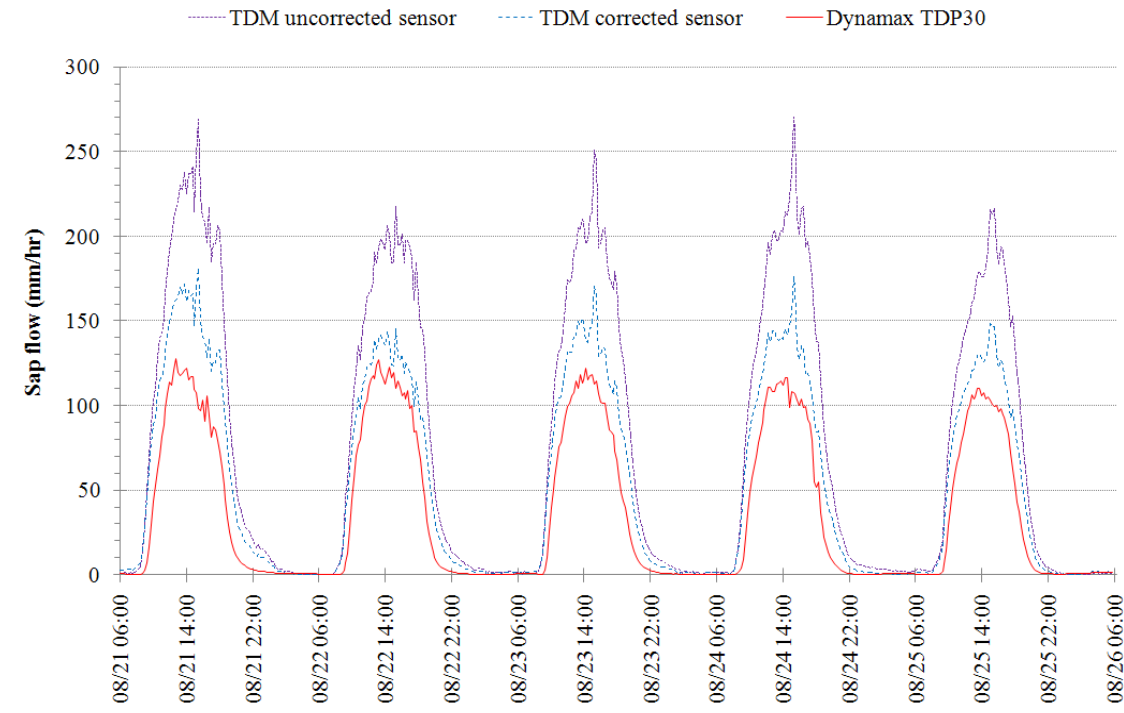
Figure 9. Comparison of sap flow calculations between the Dynamax TDP30 sensor (solid red line), temperature-corrected self-made TDM sensor (dashed blue line) and uncorrected self-made TDM senor (dotted purple